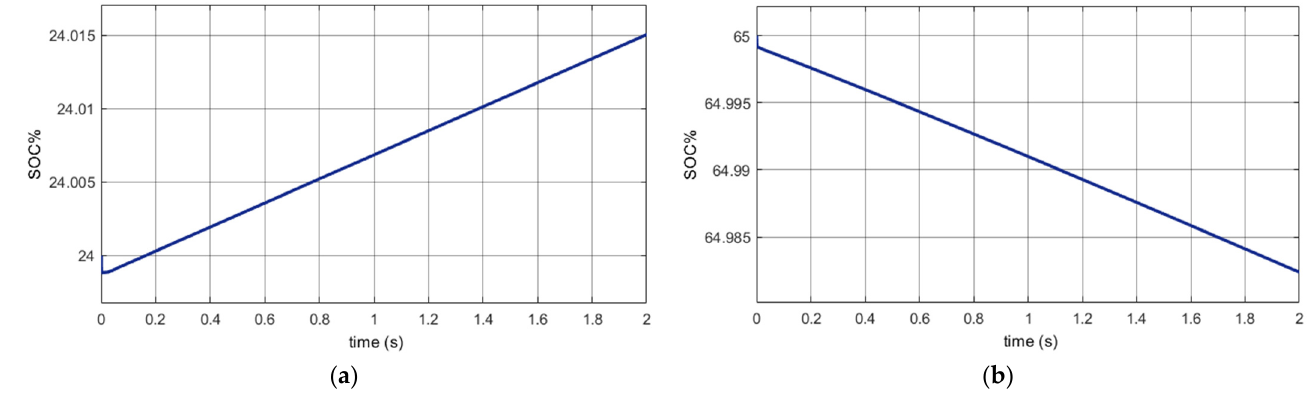
Figure 12. Power distribution in the system.